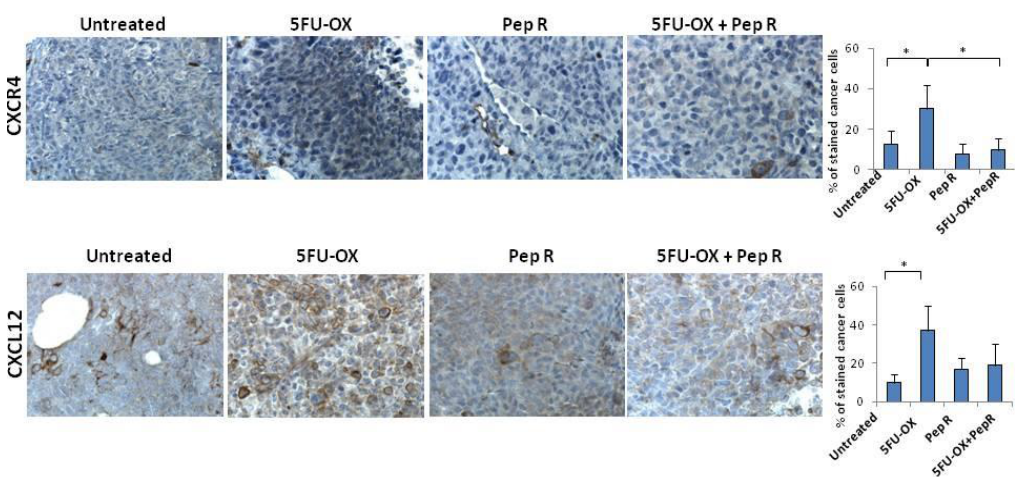
Figure 2. Peptide R modulates CXCR4 in CT treated HCT116 human colon cancer xenograft. Immunohistochemistry staining (200× magnification) for CXCR4 and CXCL12. Bar graph illustrating quantifications of IHC staining from collected tumors (means ± SD). A p -value < 0.05 (*) was considered statistically significant (Kruskal-Wallis test followed by Dunn’s multiple comparison). Percentage of stained cancer cells y axis (y-axis); treatments (x-axis). Cancers 2020 , 12 , x